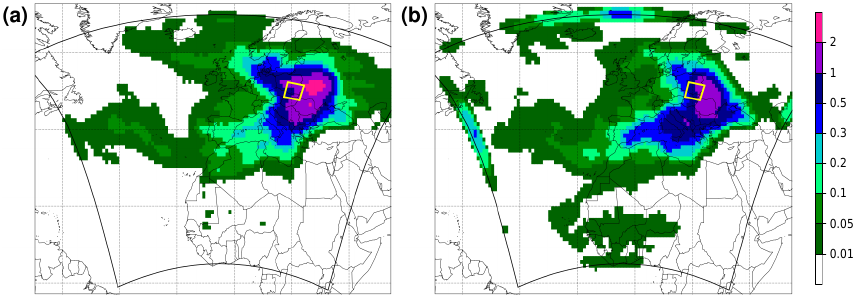
Figure 8. Moisture sources for the May 2010 precipitation event identified with the Lagrangian approach. The maps show moisture uptakes (in units of mm (72h) − 1 ) for the precipitation in the target region specified in Fig. 3a accumulated from 00:00UTC on 15 May to 00:00UTC on 18 May 2010. (a) shows moisture uptakes within the ABL; (b) shows the free tropospheric uptakes. The black frame in both panels indicates the model domain of the COSMO simulation; the yellow box shows the target region. Note the non-linear